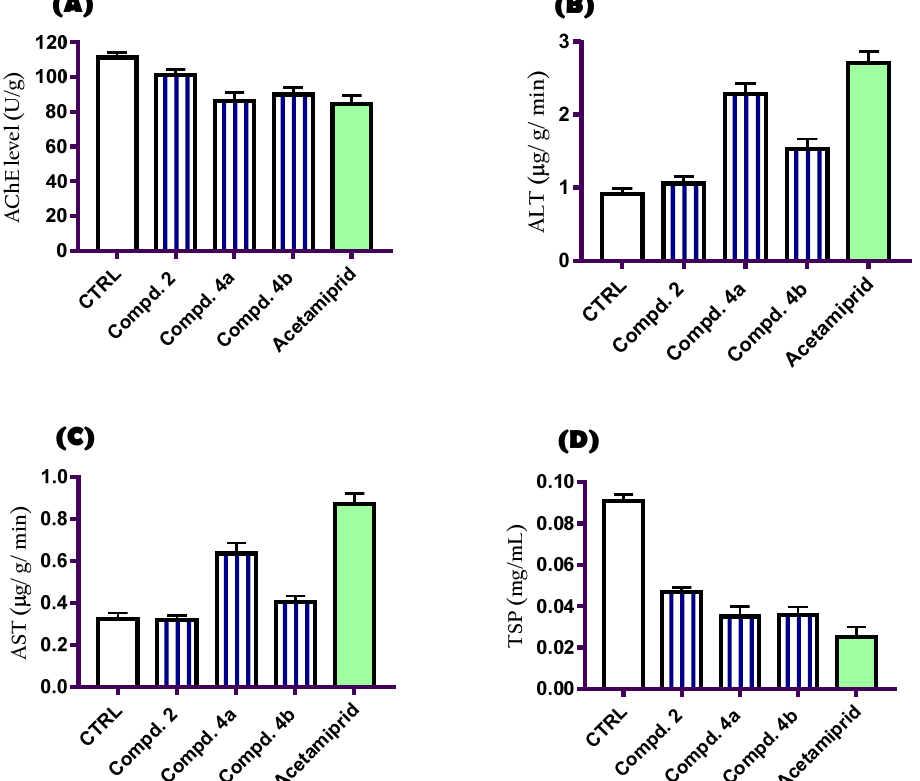
Figure 4. Impact of nicotinonitrile molecules 2, 4a , 4b and Acetamiprid on the levels of AChE, ALT, AST, and TSP at their LC 50 values (mg/mL) in M. cartusiana land snails. ( A ) Effect of tested molecules on AChE; ( B ) effect of tested molecules on ALT; ( C ) effect of tested molecules on AST; ( D ) effect of tested molecules on TSP.